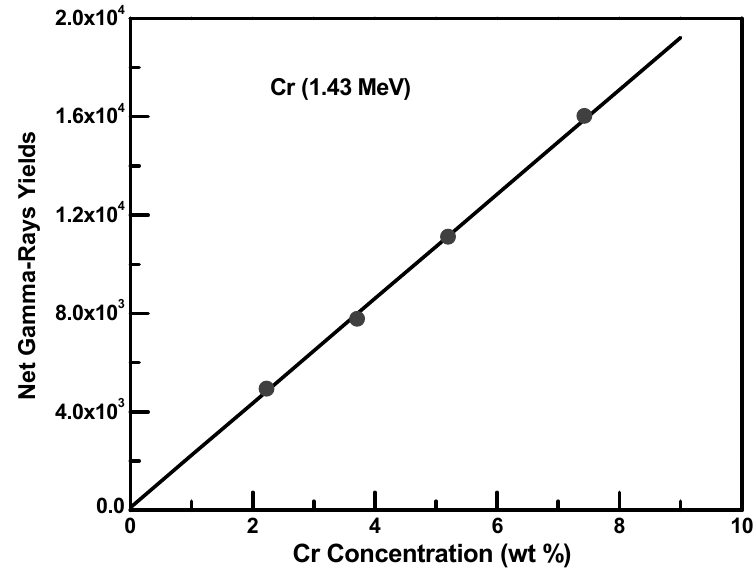
Figure 6. The normalized net counts of 1.43 MeV prompt gamma rays of chrome powder added to pure soil samples in different concentrations. The solid line represents the best fit for the data using the inverse variance weighting scheme.